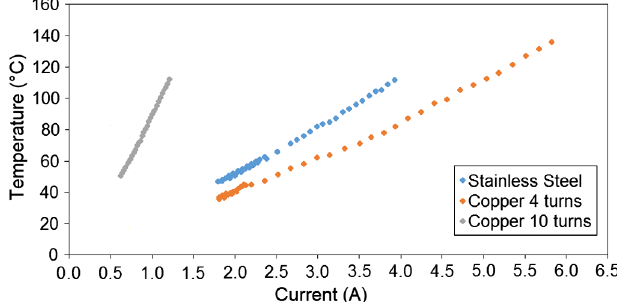
FIG. 10. Temperature response of the different oven configu- rations as a function of current.